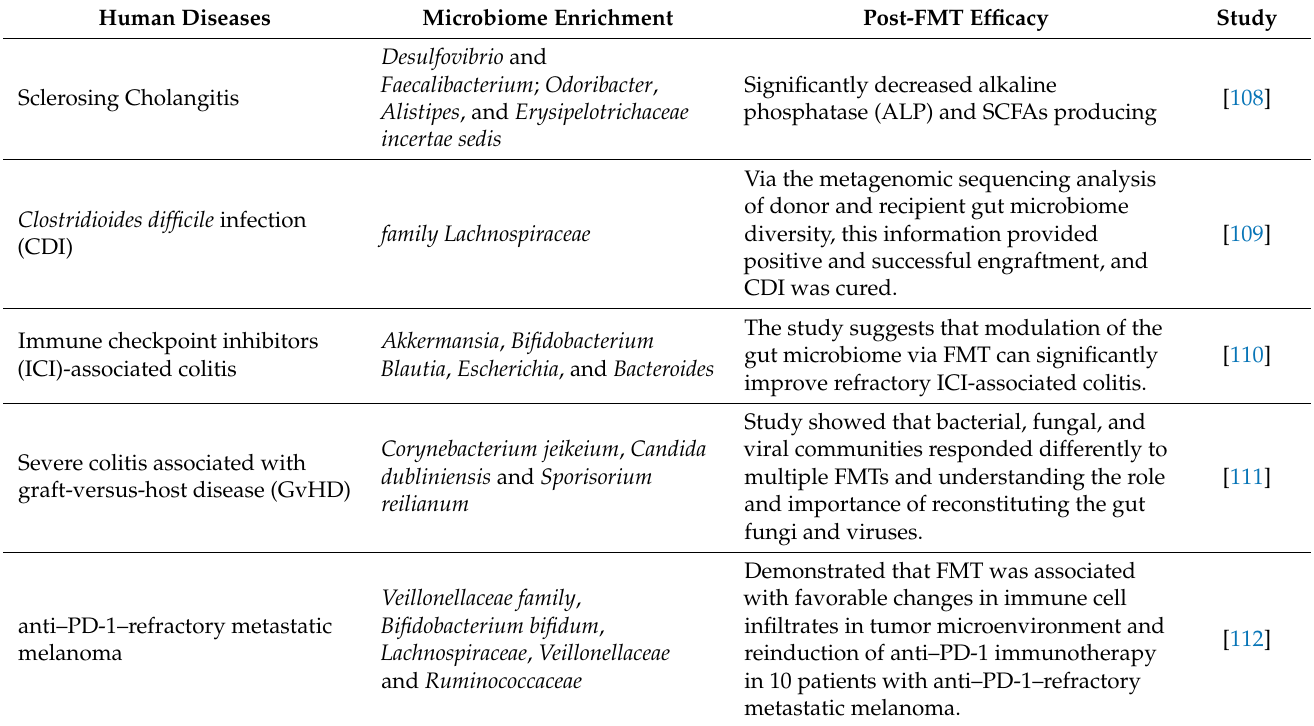
Table 2. Characterize therapeutic efficacy of fecal microbiota transplantation in clinical